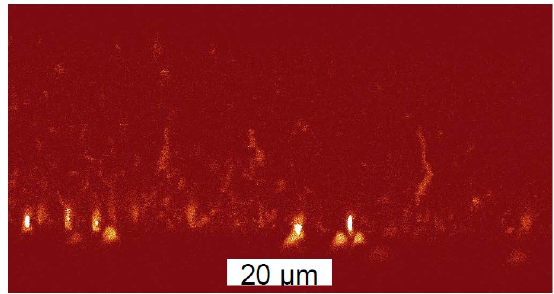
Figure 6: Luminescence image (pulsed (75 fs) excitation at 700 nm, emission recorded in the range 410–650 nm) from a XZ scan, per- pendicular to the glass plane. The electron tracks pointing away from the substrate plane are visible inside the immersion oil cov- ering the gold particles. The bright spots along the lower horizon originate from gold particles. The line by line scan starts on the top, confirming that the tracks originate from a prior